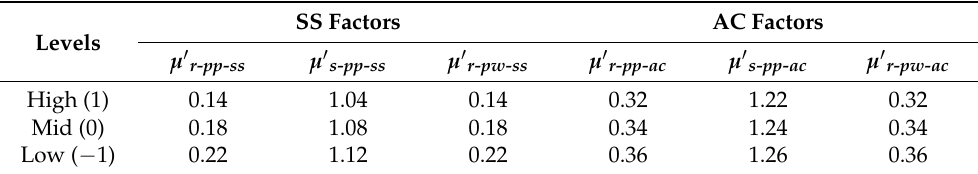
Table 4. Factors and levels.